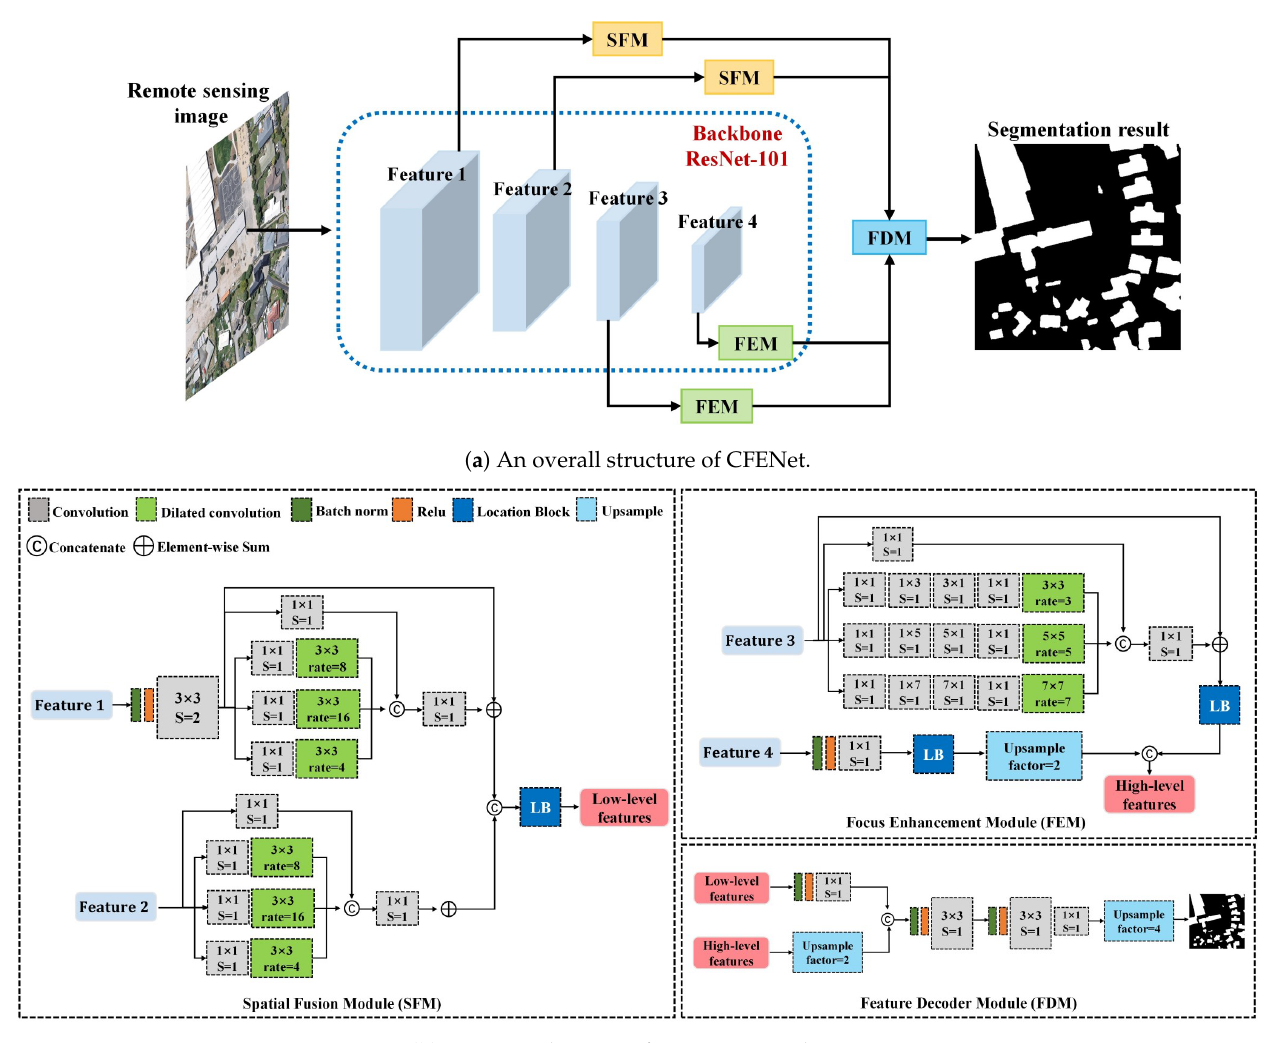
Figure 1. Our network Context Feature Enhancement Network (CFENet) adopts a ResNet-101 as the backbone. It consists of three novel modules: Spatial Fusion Module (SFM), Focus Enhance- ment Module (FEM), and Feature Decoder Module (FDM). The input image size of our network is 512 × 512 pixels, and the outputs of the four stages of ResNet-101 are used as Feature 1, Feature 2, Feature 3, and Feature 4, respectively. Then Feature 1 and Feature 2 are fed into the SFM, and Feature 3 and Feature 4 are fed into the FEM. Finally, we input the FDM to obtain the final segmentation result. ( a ) An overall structure of CFENet. ( b ) Structure diagram of SFM, FEM, and